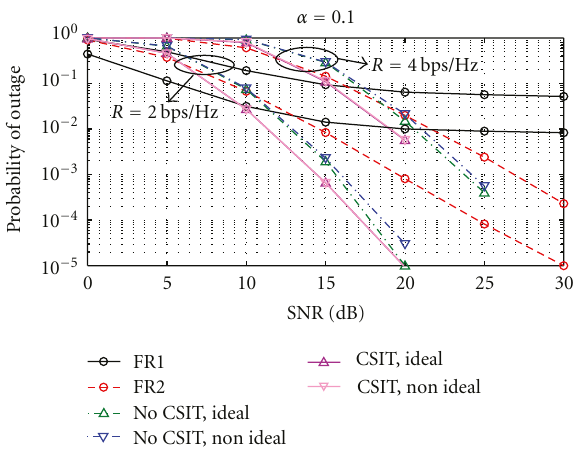
Figure 3: The joint probability of outage of M 0 and M 1 , as a function of the SNR (dB), for two isolated base stations and two target spectral e ffi ciencies ( R = 2 bps/Hz and R = 4bps/Hz), for both the FR1 and the FR2 scenarios. The link quality is α = 0 . 1. The non ideal link denotes the case when the base station-to-base station link gain is β = α .